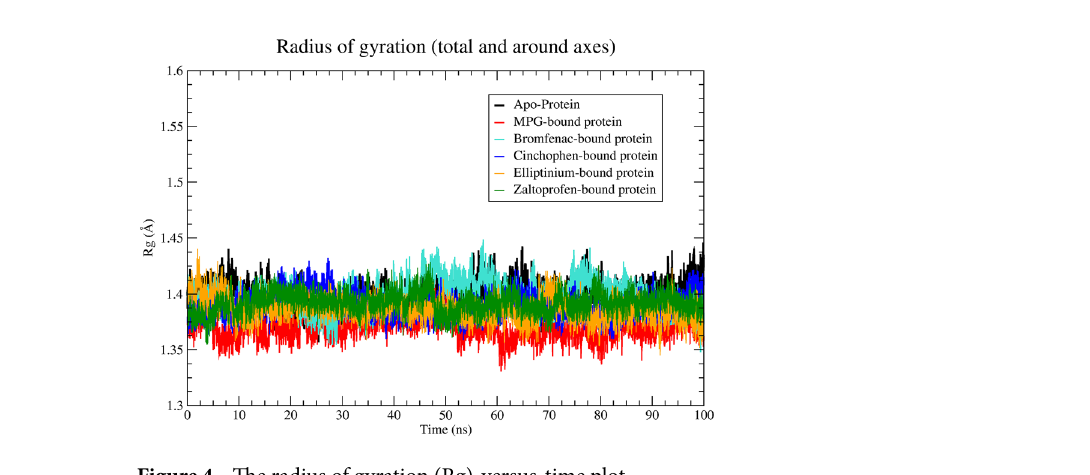
Figure 4. The radius of gyration (Rg)-versus-time